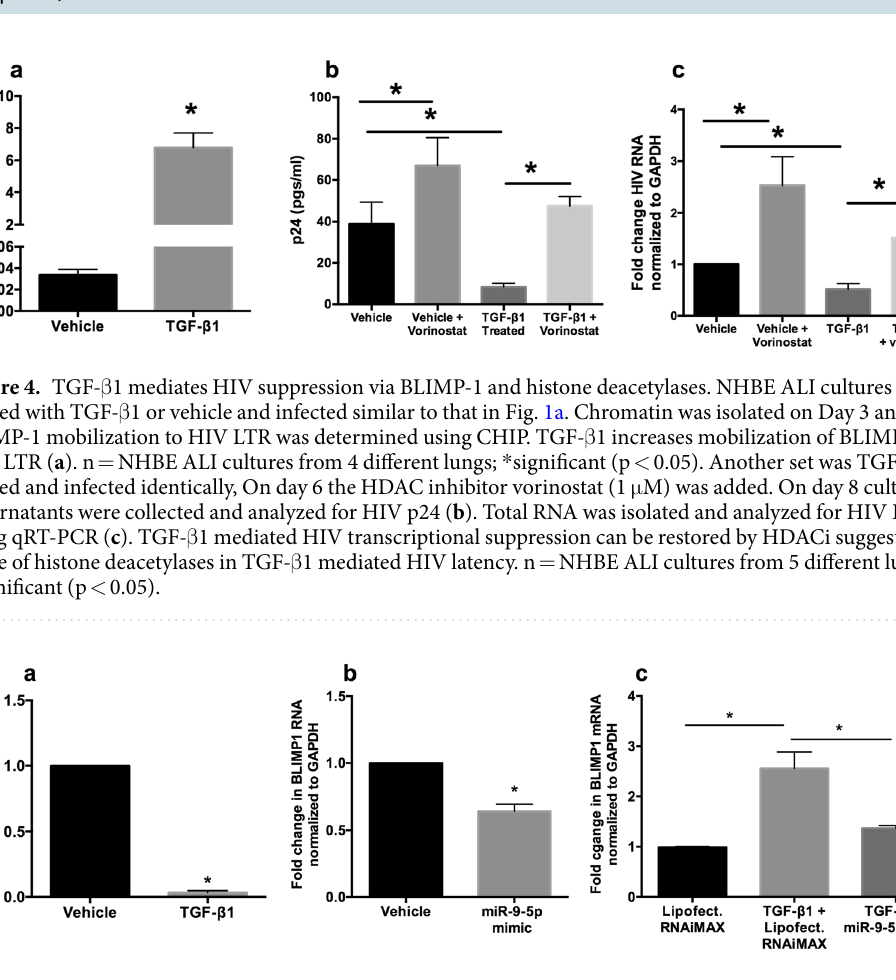
tGf- β 1 upregulates BLIMP-1 by suppressing miR-9-5p. TGF- β signaling has been shown to alter miRNA homeostasis 34,35 . In our previous report, we have demonstrated that TGF- β suppresses miR-141-5p to increase expression of CCR5 receptor. We tried to determine if TGF- β mediated BLIMP-1 upregulation is a con- sequence of miRNA mediated regulation. Analysis of literature revealed a potential link between TGF- β signal- ing, miR-9-5p and BLIMP-1. miR-9-5p has been shown to regulate BLIMP-1 36,37 , while TGF- β has been shown to epigenetically suppress miR-9-5p expression 38 . In our recent report, a microRNAome analysis of TGF- β 1 treated NHBE ALI cultures demonstrated a Log2 fold suppression of − 4.45 in expression of miR-9-5p 39 . We used a sys- tematic approach to identify the role of miR-9-5p in TGF- β mediated BLIMP-1 upregulation. We first tried to validate our miRNA array data to determine if TGF- β suppresses miR-9-5p in primary bron- chial epithelial cells. NHBE ALI cultures were treated with recombinant TGF- β 1 (vehicle as control). As seen in Fig. 5a, TGF- β 1 completely abrogates miR-9-5p expression in NHBE ALI cultures. Next, we tried to determine if miR-9-5p suppresses BLIMP-1. For these experiments, we used transient transfection of the miR-9-5p mimic in BEAS-2B airway epithelial cells. This is because BEAS-2B cells are readily transfected with a higher transfection efficiency compared to primary bronchial epithelial cells. BEAS-2B airway epithelial cells were transfected with miR-9-5p mimic (20 nM) using lipofectamine RNAiMAX according to manufacturer’s instructions. Forty-eight hours post-transfection, total RNA was isolated and quantitated for BLIMP-1 expression. As seen in Fig. 5b, miR- 9-5p mimic suppresses BLIMP-1 mRNA. Next, we tried to determine if miR-9-5p mimics can reverse TGF- β